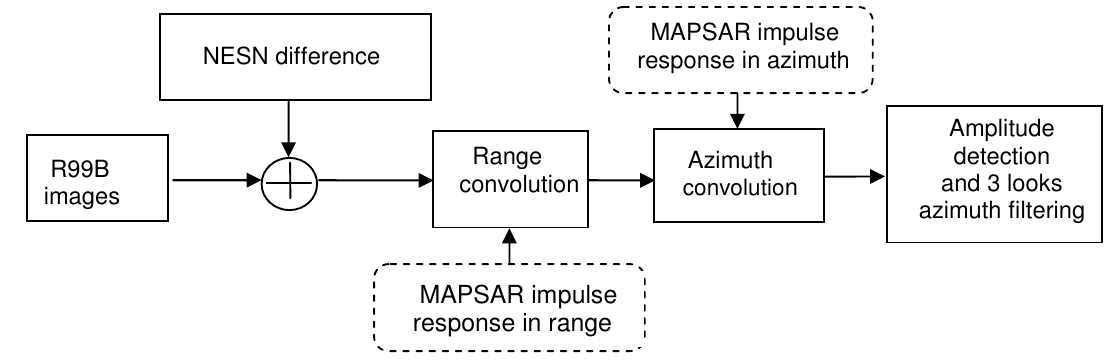
Figure 8. Processing flow of radiometric filtering to simulate the MAPSAR image.